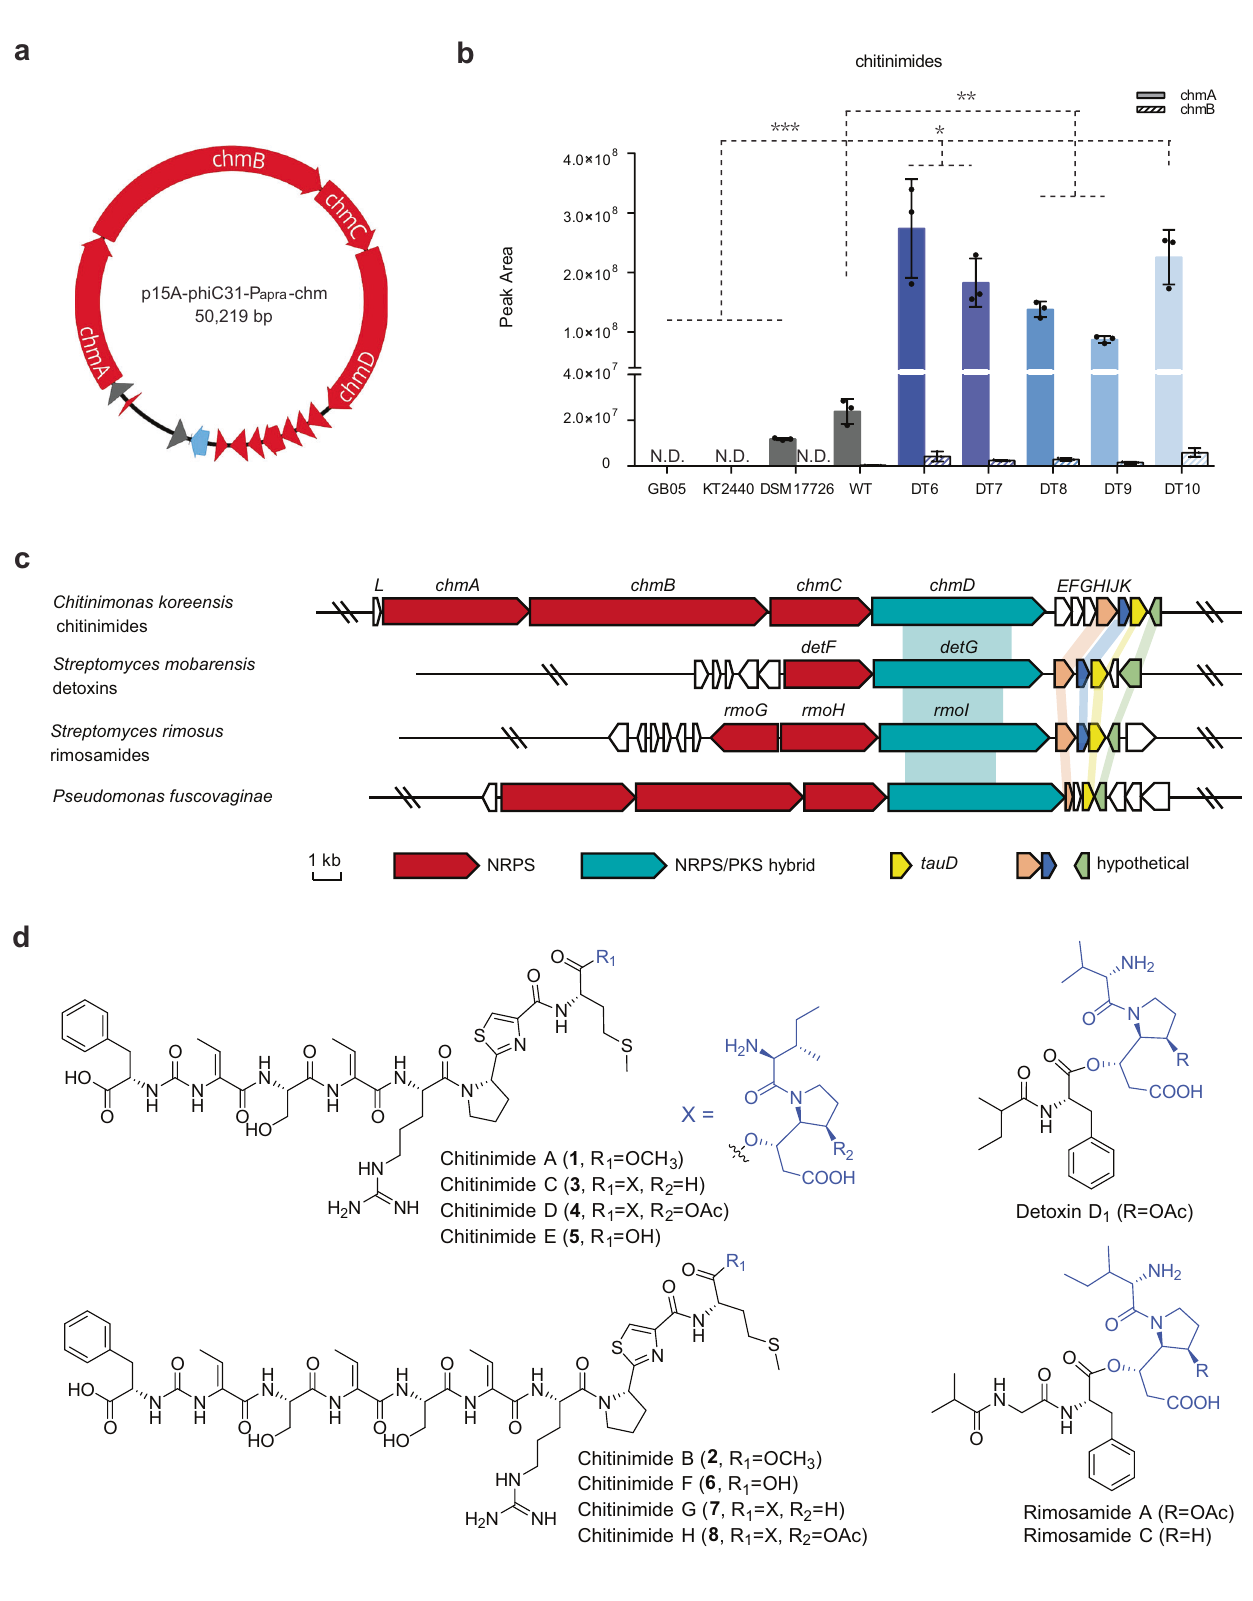
Chitinimide B ( 2 ) was also isolated as a colorless oil, having a molecular formula of C 48 H 67 N 13 O 14 S 2 , as deduced from the HRESIMS ( m/z 1114.4467 [M + H] + , calcd 1114.4445). Compar- ison of NMR spectroscopic data of 1 and 2 (Fig. 6d, Supplementary Table 4, Supplementary Figs. 23 – 28) demon- strated that 2 differed from 1 only by the presence of